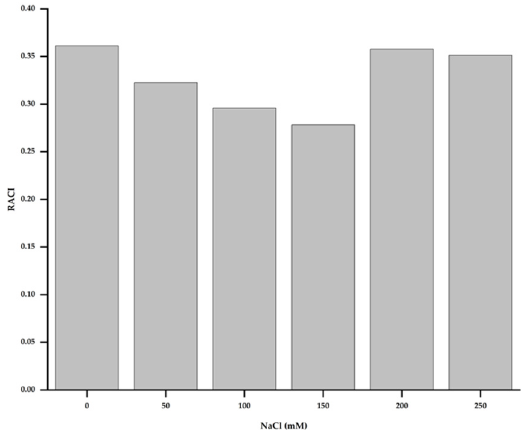
Figure 7. The relative antioxidant capacity index (RACI) was applied to combine the antioxidant capacity values from the various methods.